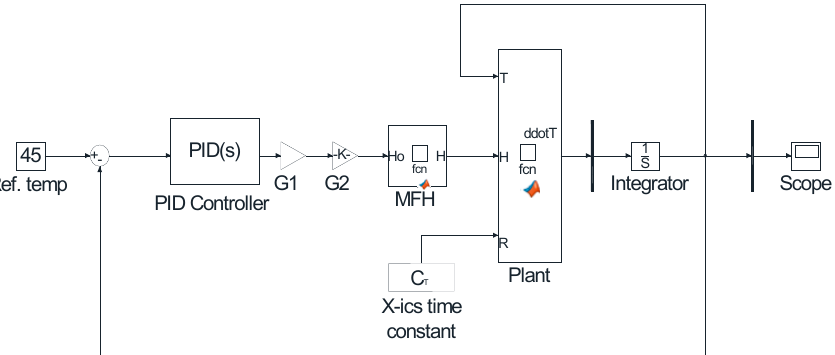
Figure 6. Simulink model of the plant with PID controller. The value of the preset temperature was set to 45 ◦ C. After adjusting the parameters and tuning the PID parameters, a step response of the system was obtained from the scope. Step response of the plant using PID, PI and PD controller is shown in Figure 7.